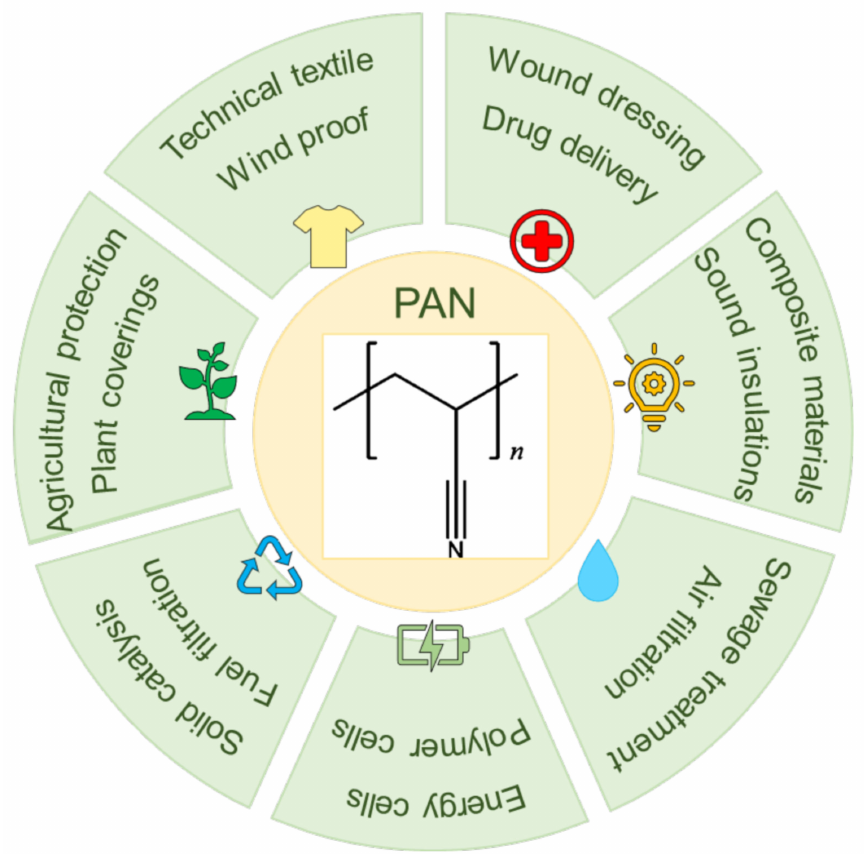
Figure 1. Applications of